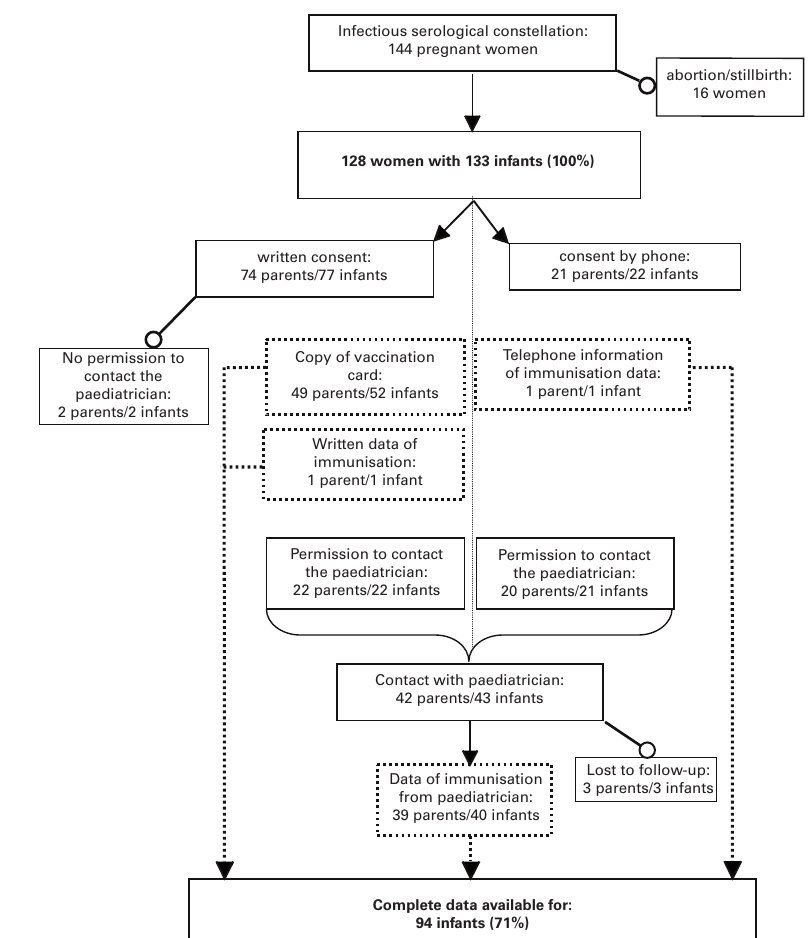
Figure 1 Patients flow